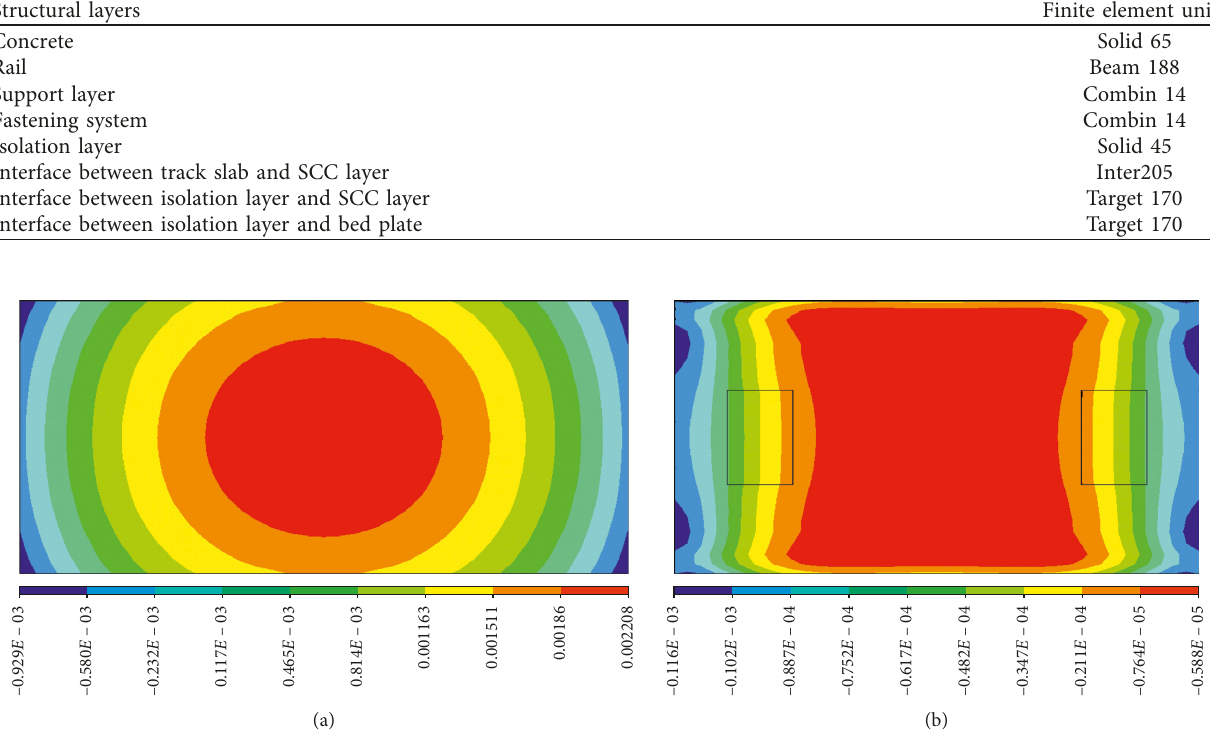
Figure 12: The deformation under 100 ° C/m temperature gradient. (a) Track slab. (b) Bed